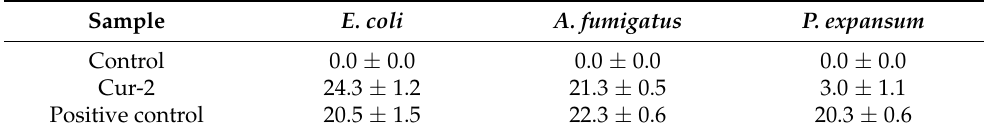
Table 7. Antimicrobial activity of the control and Cur-2 film (zone of inhibition diameter, mm). Sample E.